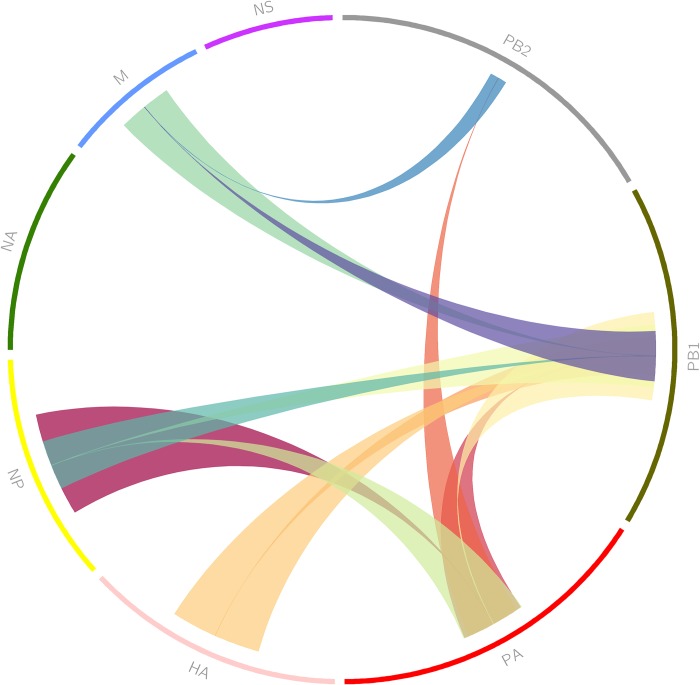
Pairwise interactions learned from MDCK cell images.Each vRNA segment is arranged around the perimeter. Bands connect vRNA segments that interact with high likelihood. The position of the base of each band indicates the independent (secondary) variable and the larger the width of the base the more likely the interaction. Only interactions whose log likelihoods are below 0.23 from Table 4 are shown.